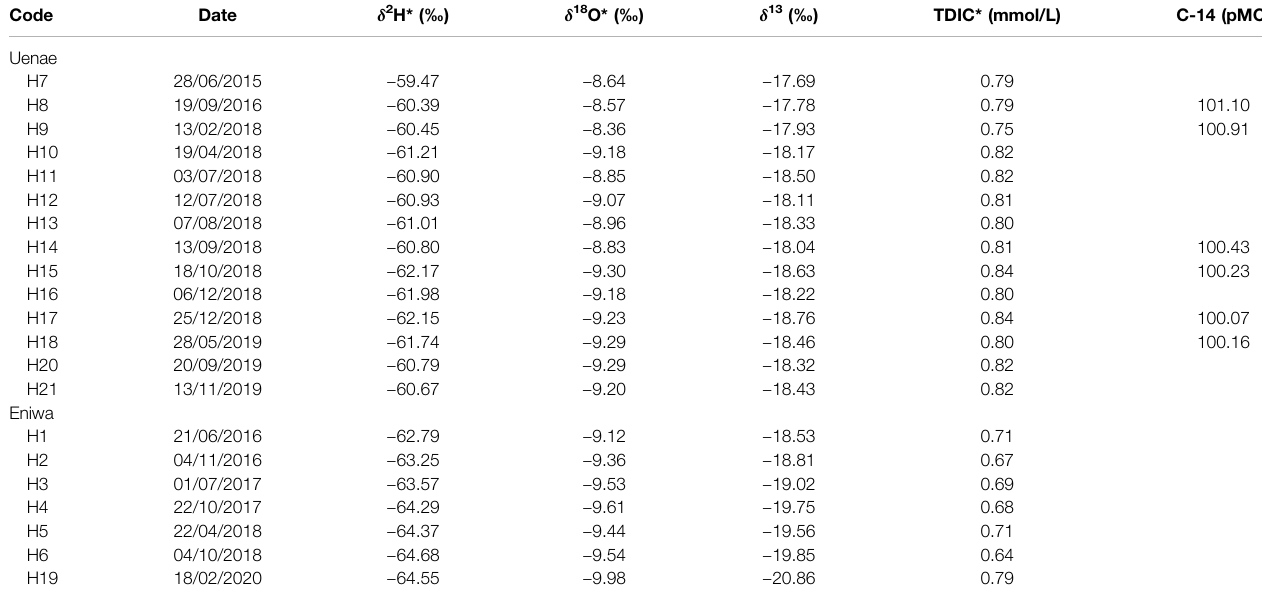
TABLE 2 | Hydrogen, oxygen and carbon isotopes together with total DIC contents of groundwater samples in Hokkaido, Japan.